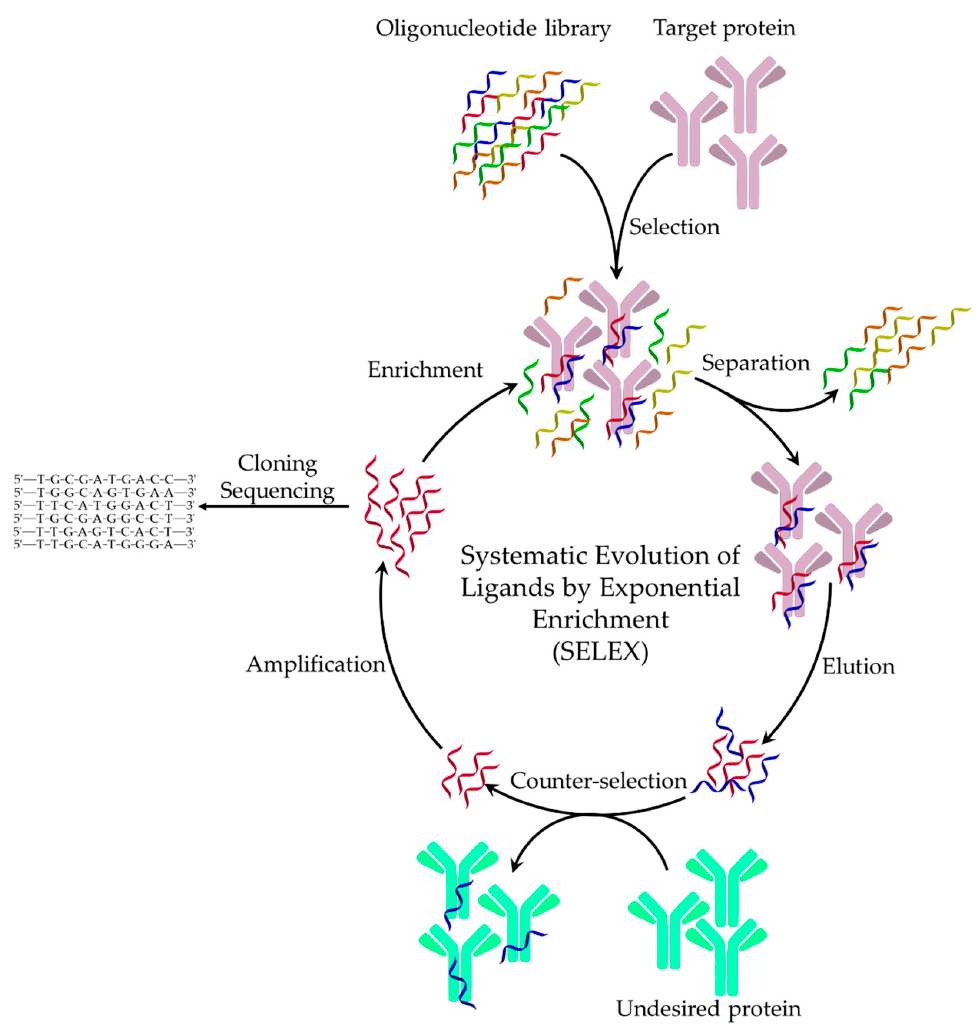
Figure 1. Schematic illustration of the SELEX procedure.